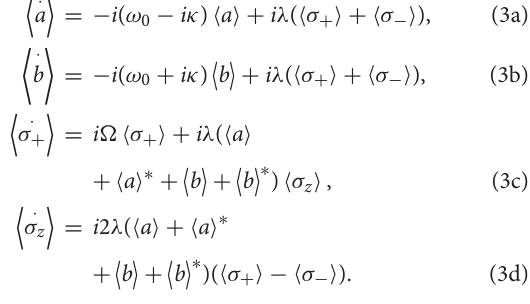
FIGURE 1 | The schematics of the dissipative QRM together with PT symmetric structure when ω a where Hamiltonian(